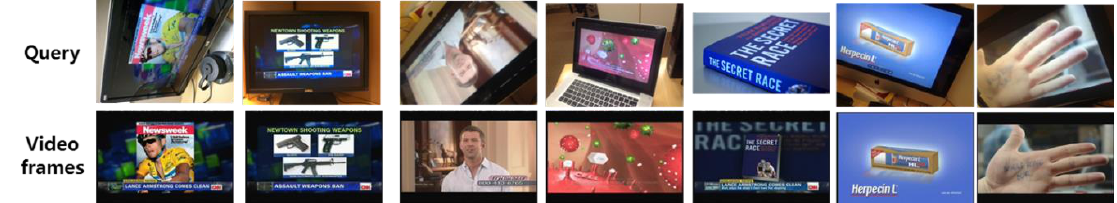
Figure 13. Examples of the query images and ground-truth database frames.